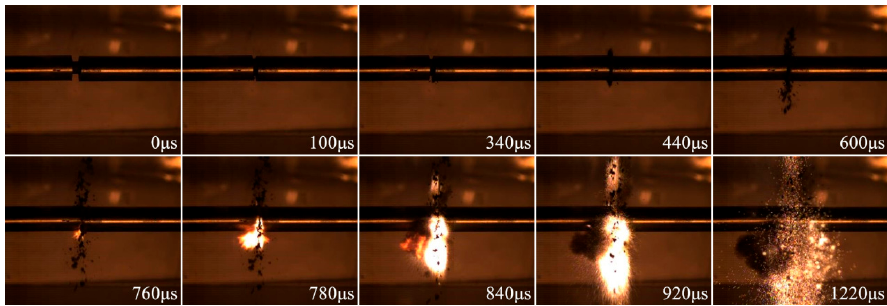
Figure 10. Video frames of 68PTFE/32Ti composites under 5980 s − 1 strain rate captured from various time points.